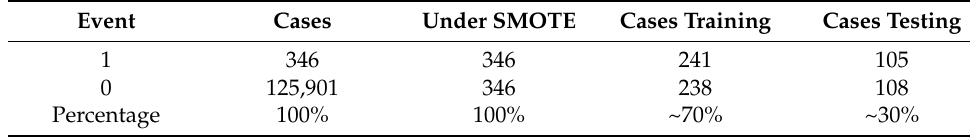
Table 4. Training and testing data—under sampling